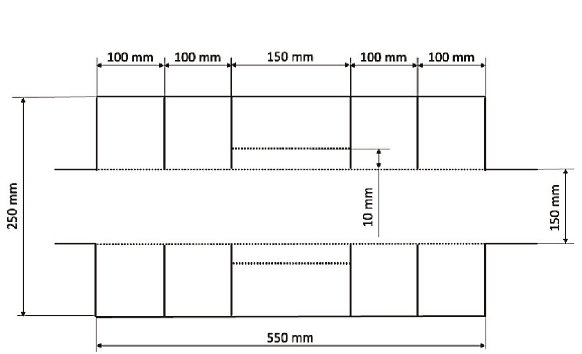
Fig. 8. A concept layout incorporating 5 expansion chambers and a microperforated inner tube and double-layer micro - perforated central chamber